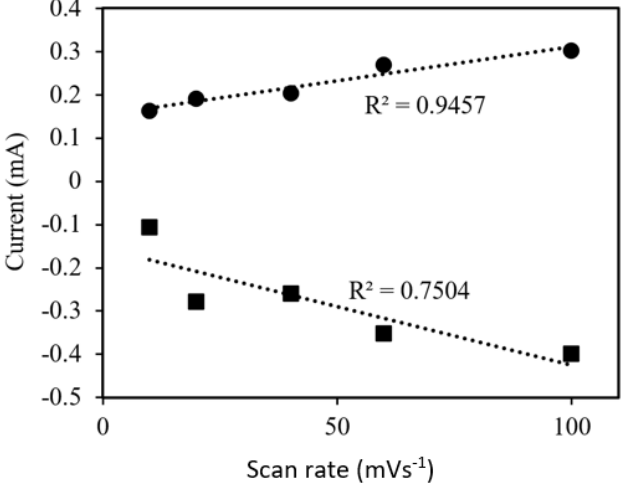
Figure 10. Relationship between scan rate and anodic ● (Ipa) and cathodic ■ (Ipc) peak